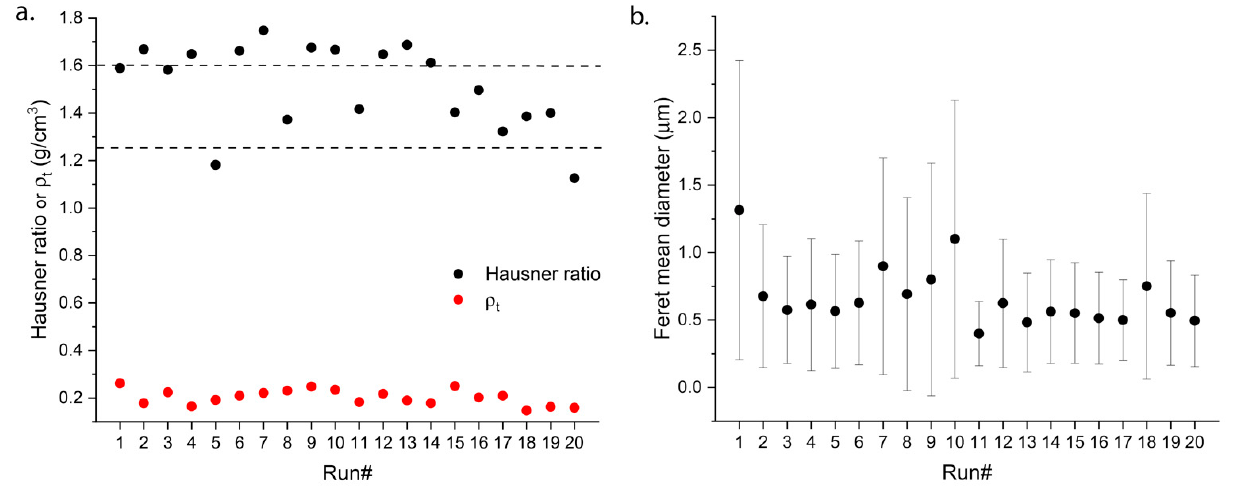
Figure 3. Theoretical flowability expressed as ( a ) H together with ρ t and size distribution expressed as ( b ) FMD ± S.D. across the different runs of the experimental design. Horizontal lines delimit flowability regions: flowing (H < 1.25), partially flowing (1.25 < H < 1.6), and non-flowing (H > 1.6) powders.